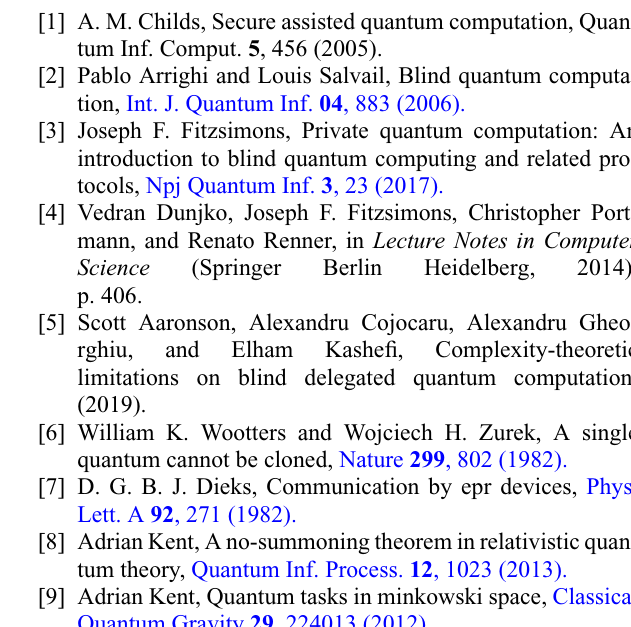
Perm 2 is applied